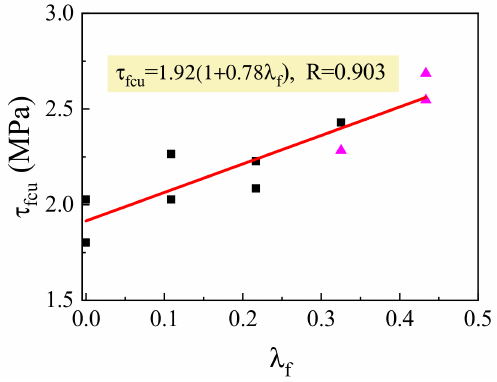
Figure 7. Changes of τ fcu with λ f